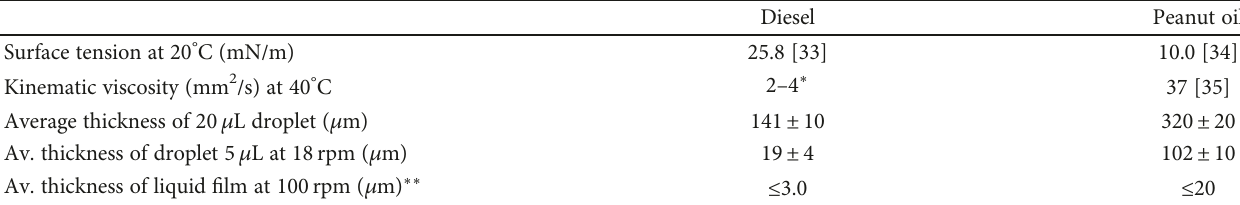
Table 1: Physical properties and the estimated droplet/ fi lm thicknesses for diesel and peanut